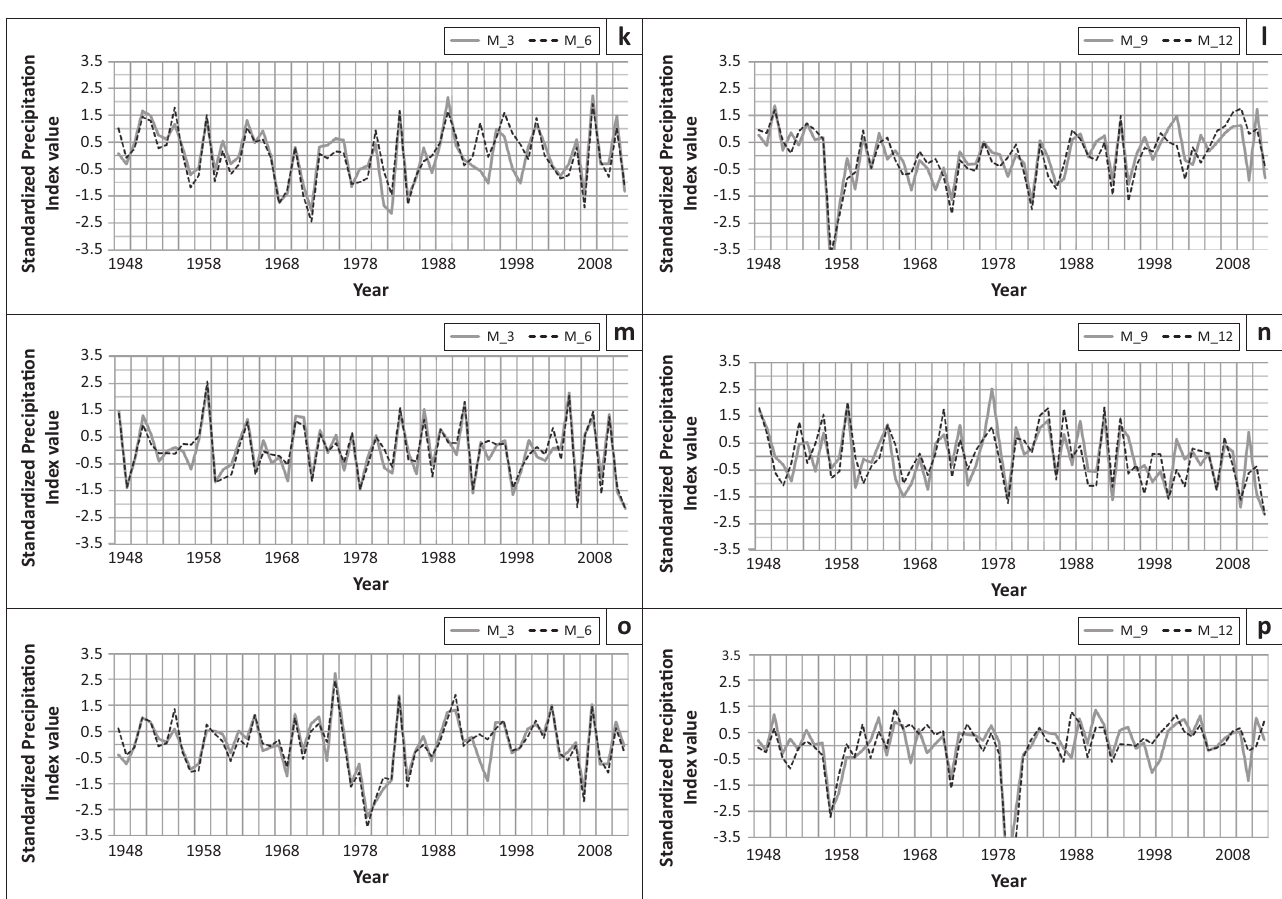
FIGURE 5 (Continues…): Drought in (a) Sylhet, (c) Srimangal, (e) Chittagong, (g) Khutubdia, (i) Sithakunda, (k) Rangamati, (m) Teknaf and (o) Cox”s Bazar based on 3-month SPI (M_3) and 6-month SPI (M_6). Drought in (b) Sylhet, (d) Srimangal, (f) Chittagong, (h) Khutubdia, (j) Sithakunda, (l) Rangamati, (n) Teknaf and (p) Cox”s Bazar based on 9-month SPI (M_9) and 12-month (annual) SPI